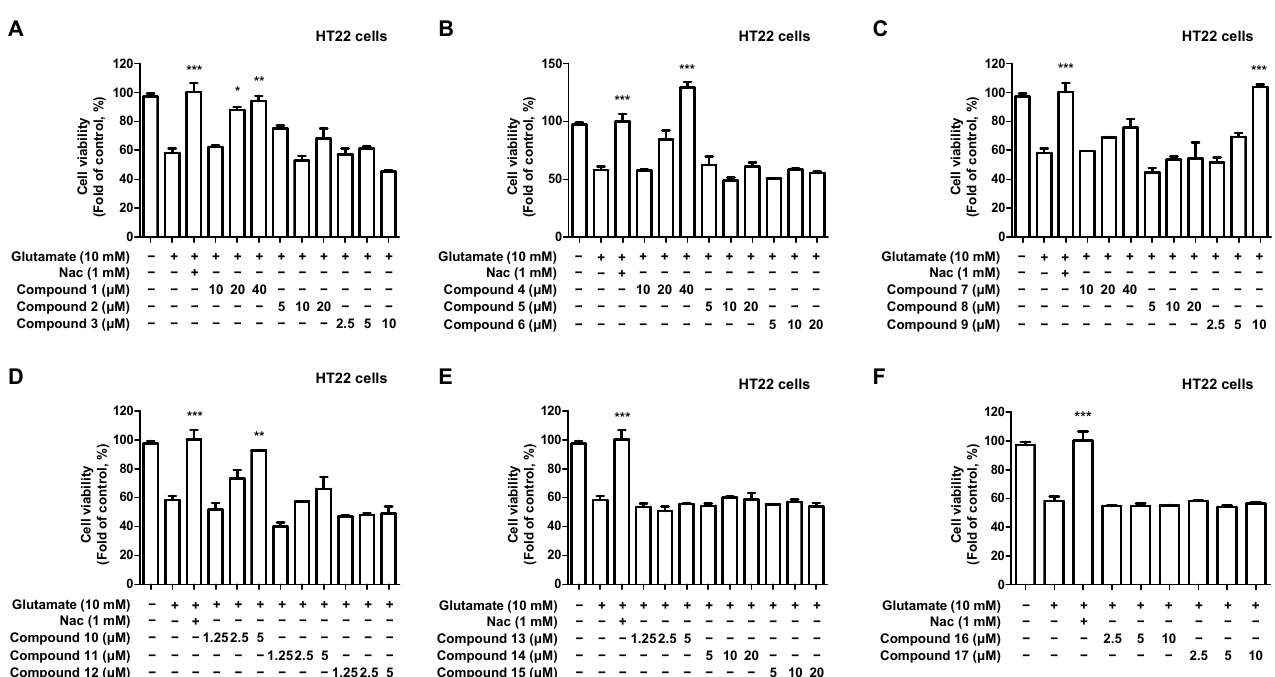
Figure 5. Effect of 17 natural compounds isolated from C. longa on the neuroprotection in glutamate- induced HT22 hippocampal cells. ( A – F ) HT22 hippocampal cells were treated with each concentration of the compound and cultured for 8 h, followed by treatment with glutamate. After glutamate treatment, the cells were cultured for 12 h, and an MTT assay was performed to determine the neuroprotective effect. The positive control group was treated with N-acetyl cysteine (Nac) 1 mM. Data are presented as the mean ± SD values of 3 independent experiments; * p < 0.05, ** p < 0.01, and *** p < 0.001 compared with glutamate.